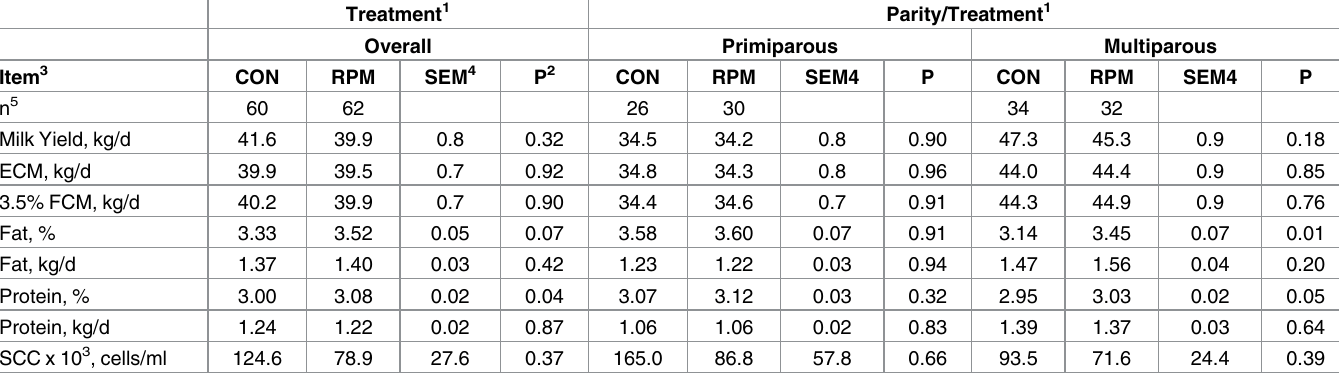
Table 3. Effect of rumen-protected methionine feeding (RPM) on production variables analyzed for all cows and by parity. Treatment